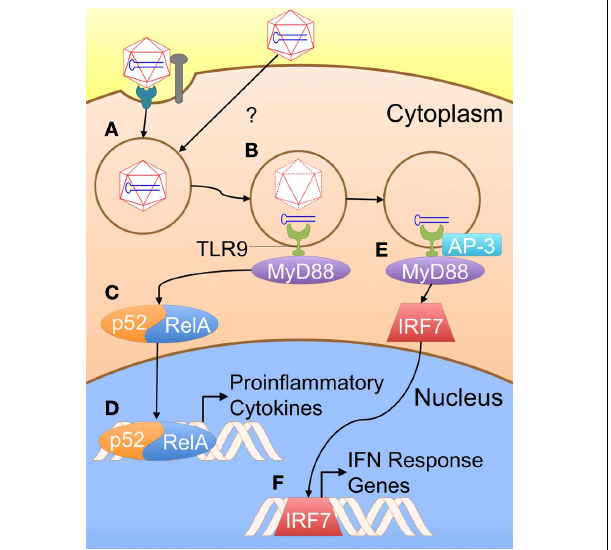
FIGURE 1 |A proposed model for innate immune recognition ofAAV vectors (based onTLR9 dependence of the response and general knowledge ofTLR9 signaling). (A) AAV particles are taken up by APCs; the exact mechanism of uptake in these cell types is not presently known. Typically, AAV is taken up via receptor/co-receptor interactions that lead to internalization in a clathrin-coated pit. However, viral particles might also enter APCs through other pathways such as pinocytosis. (B) Some capsid breaks down in the endosome, exposing the genome toTLR9. (C) MyD88 initiates a signaling cascade, resulting in activation of NF- κ B1 (p52–RelA heterodimer). (D) NF- κ B enters the nucleus, initiating transcription of pro-inflammatory cytokines. (E) Alternatively,TLR9 may be rerouted to a LAMP2 + compartment by AP-3, allowing it to activate IRF7. (F) IRF7 translocates into the nucleus, inducing transcription of interferon response genes, including IFN α / β